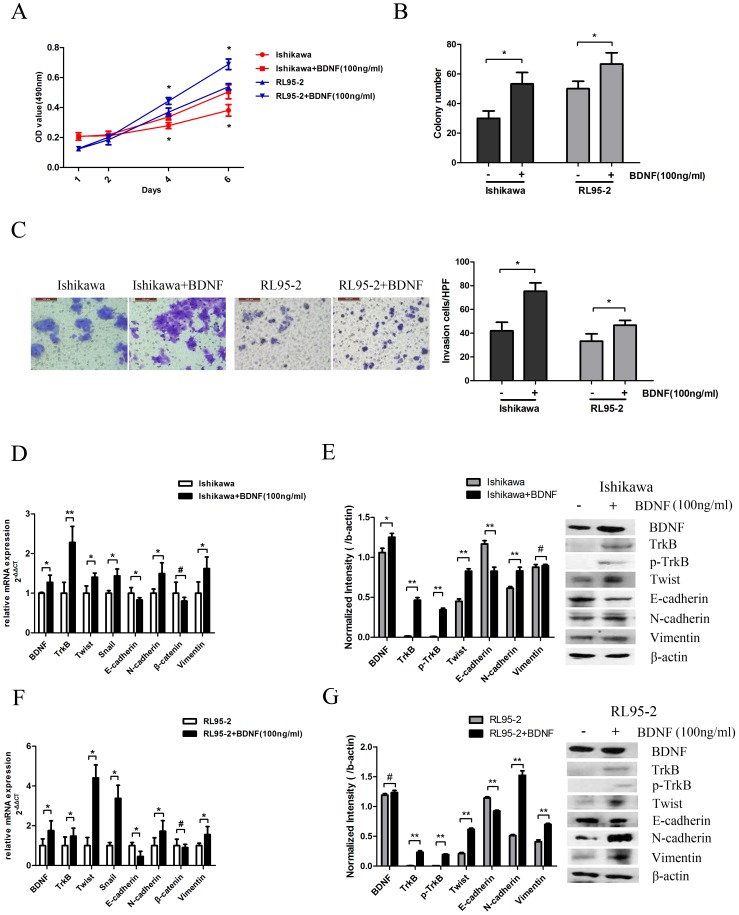
Activation of TrkB by BDNF promotes carcinogenesis in EC.A. After BDNF (100 ng/ml) treatment for 24 h, the effects on the proliferation of Ishikawa and RL95-2 cells were determined by MTT assay (*p<0.05). B. BDNF(100 ng/ml) treatment for 24 h promoted tumor growth of Ishikawa and RL95-2 cells as assessed by colony formation in soft agar (*p<0.05). C. Left: Cell invasion was detected in transwell chambers with or without 24 h BDNF (100 ng/ml) treatment (200×). Representative images are shown. Right: Graphical representation of the fold change in the number of invasive cells in Ishikawa and RL95-2 cells following BDNF treatment. *p<0.05 is considered significant. Bars show mean ± SD. D. mRNA levels of BDNF, TrkB, and EMT markers as analyzed in Ishikawa cells by qRT-PCR 24 h after BDNF treatment. β-actin was included as an internal control (*p<0.05, **p<0.01; #, not significant). E. Protein levels of BDNF, TrkB, and EMT markers as analyzed in Ishikawa cells by Western blotting 48 h after BDNF treatment (Right), and further quantification by densitometry of triplicates (Left, *p<0.05, **p<0.01; #, not significant). β-actin was included as an internal control. F. mRNA levels of BDNF, TrkB, and EMT markers in RL95-2 cells as analyzed by qRT-PCR 24 h after BDNF treatment. β-actin was included as an internal control (*p<0.05; #, not significant). G. Protein levels of BDNF, TrkB, and EMT markers as analyzed in RL95-2 cells followed by Western blotting 48 h after BDNF treatment (Right). The results were further quantified by densitometry of triplicates (Left, **p<0.01; #, not significant). β-actin was included as an internal control. All experiments were carried out in triplicate and repeated at least three times.